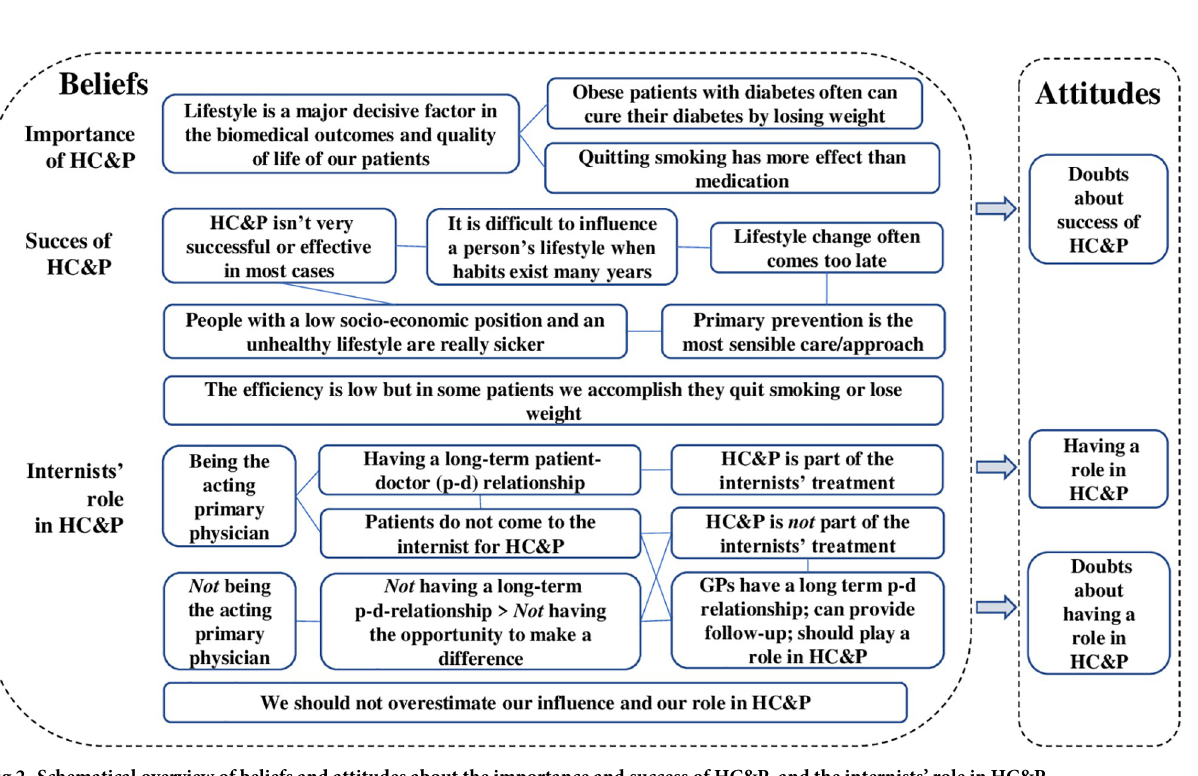
PLOS ONE | https://doi.org/10.1371/journal.pone.0273848 September 1,